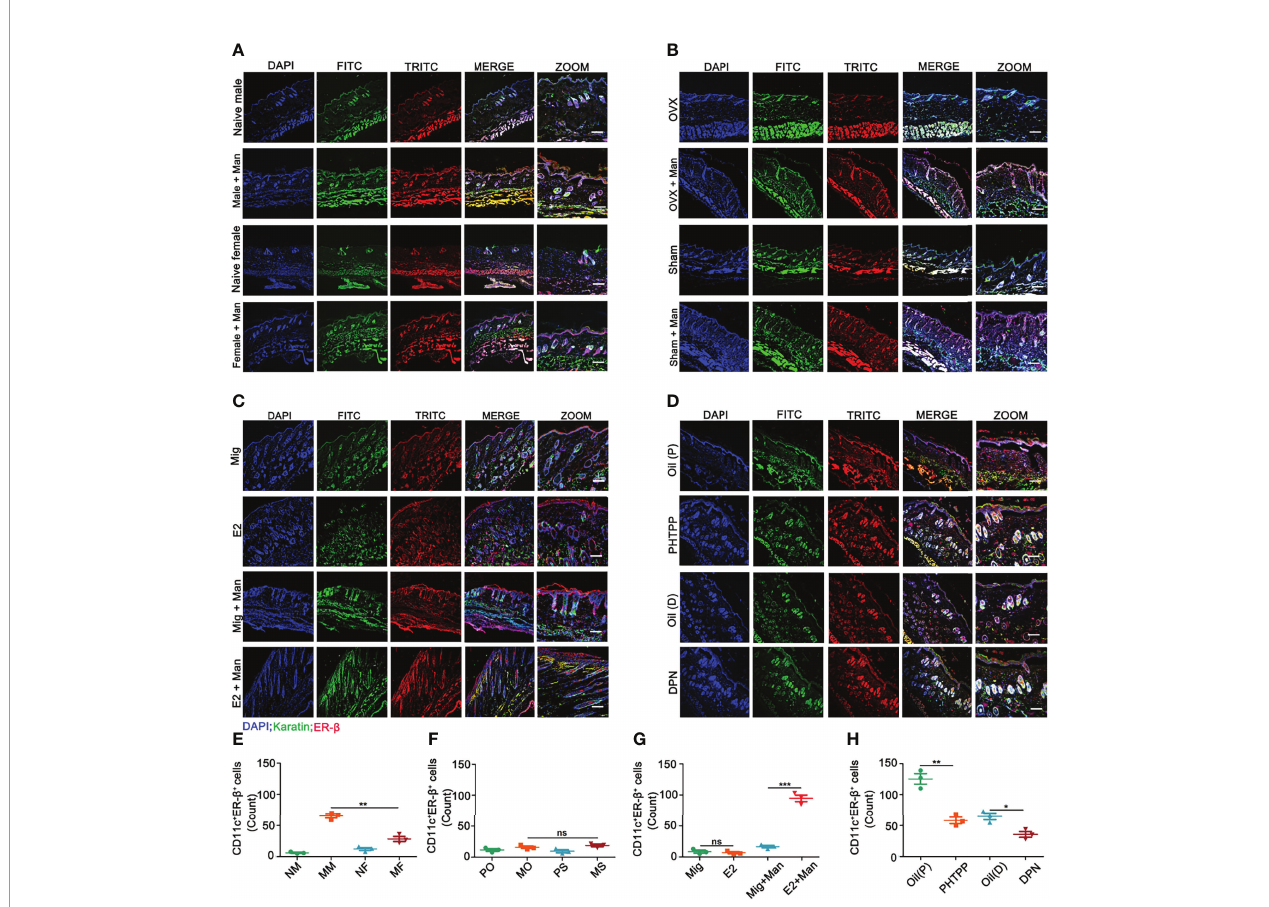
FIGURE 6 | Estrogen increased ER- b expression in CD11c + cells in the in fl amed skin. (A) Immuno fl uorescence staining of ER- b (red) and CD11c (green) double positive cells in male and female mice under normal and in fl ammatory conditions (n = 3/group); effect of (B) endogenous estrogen, (C) 17- b -estradiol, (D) ER- b antagonist or agonist on the expression of ER- b and CD11c double positive cells (n = 3/group). (E – H) Quanti fi cation of CD11c + ER- b + positive cells by immuno fl uorescence (n = 3/group). Scale bar: 200 µm. Nuclei were counterstained with DAPI (blue). Representative pictures are shown. Statistical analyses were performed using an unpaired t test. Man, Mannan; NM, Naive Male; MM, Man + Male; NF, Naive Female; MF, Man + Female; PO, PBS + OVX; MO, Man + OVX; PS, PBS + Sham; MS, Man + Sham; Mig, miglyol; E2, 17- b -estradiol; Oil (P), E2 + Corn oil + Man; PHTPP, E2 + PHTPP +Man; Oil (D), Corn oil + DPN; DPN, DPN